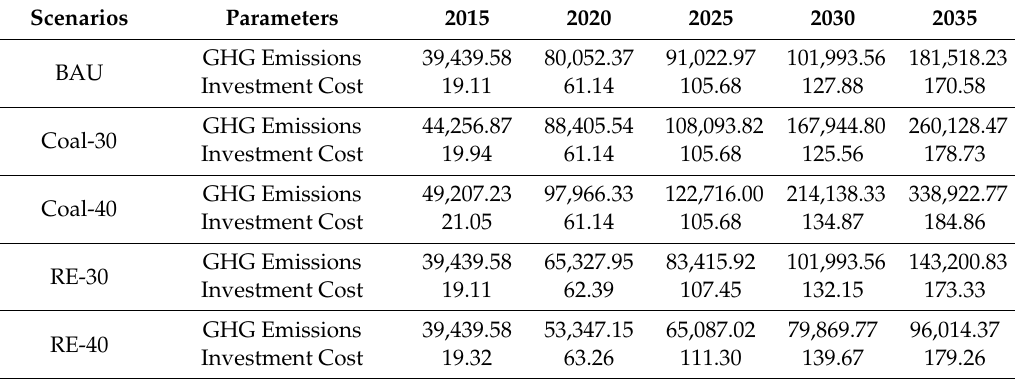
Table 7. GHG emissions and investment cost across various